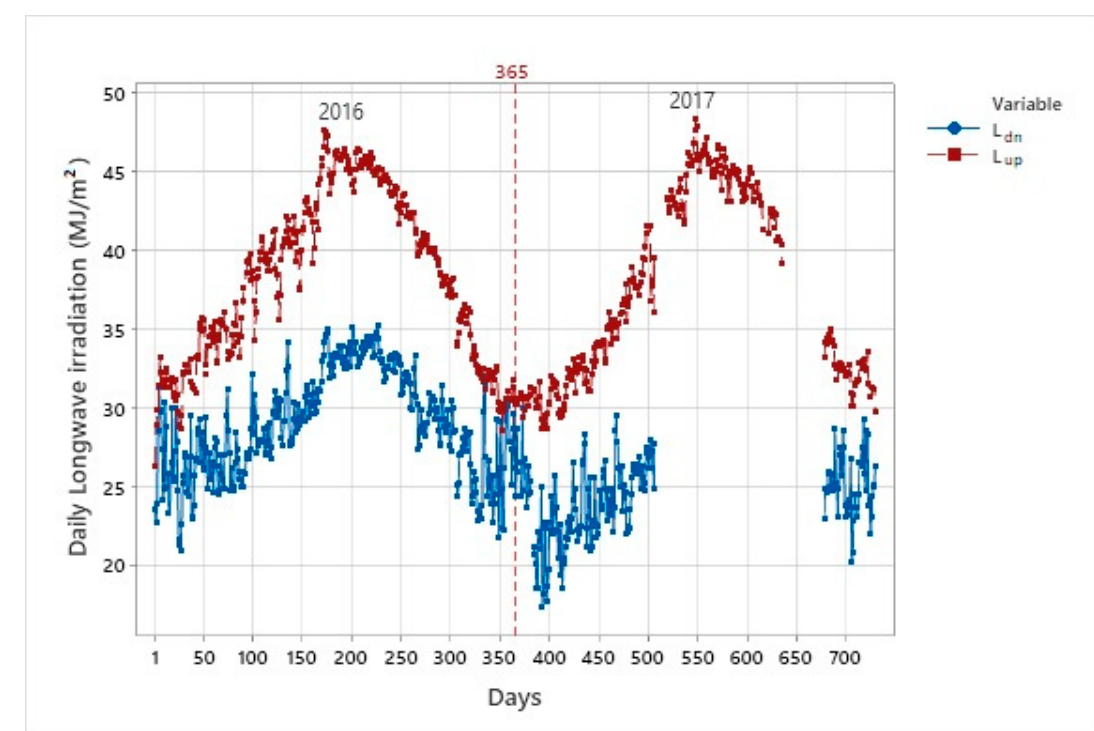
Figure 11. Daily downward and upward longwave irradiation at Athalassa, during the period 2016–2017. The monthly statistics of daily downward and upward longwave irradiation is